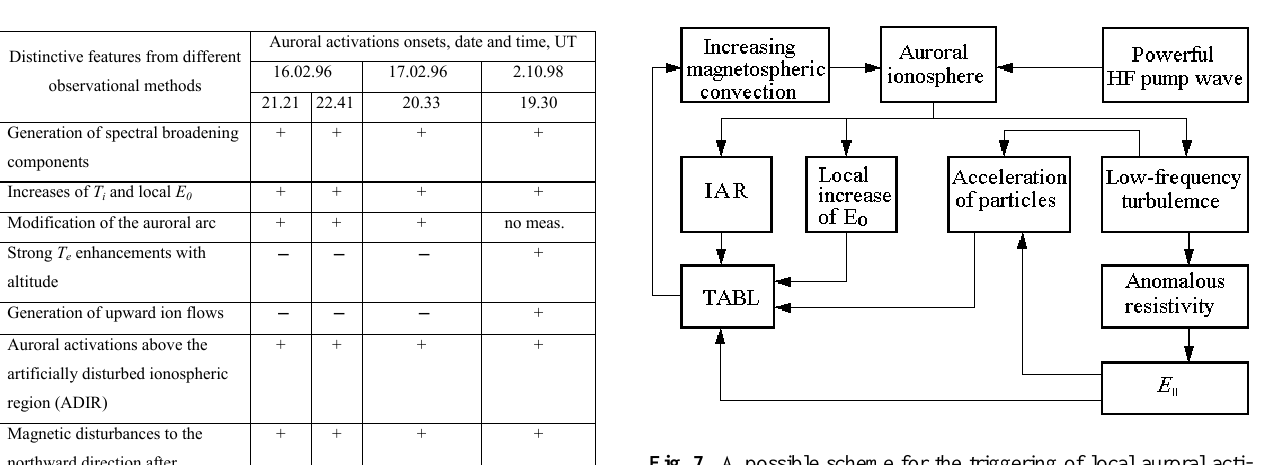
Fig. 7. A possible scheme for the triggering of local auroral acti- Figure 7. A possible scheme for the triggering of local auroral activations due to HF vations due to HF pumping into nightside auroral ionosphere. IAR pumping into night-side auroral ionosphere. IAR is the ionospheric Alfvén resonator; is the ionospheric Alfv´en resonator; TABL is the turbulent Alfv´en boundary TABL is the turbulent Alfvén boundary layer.